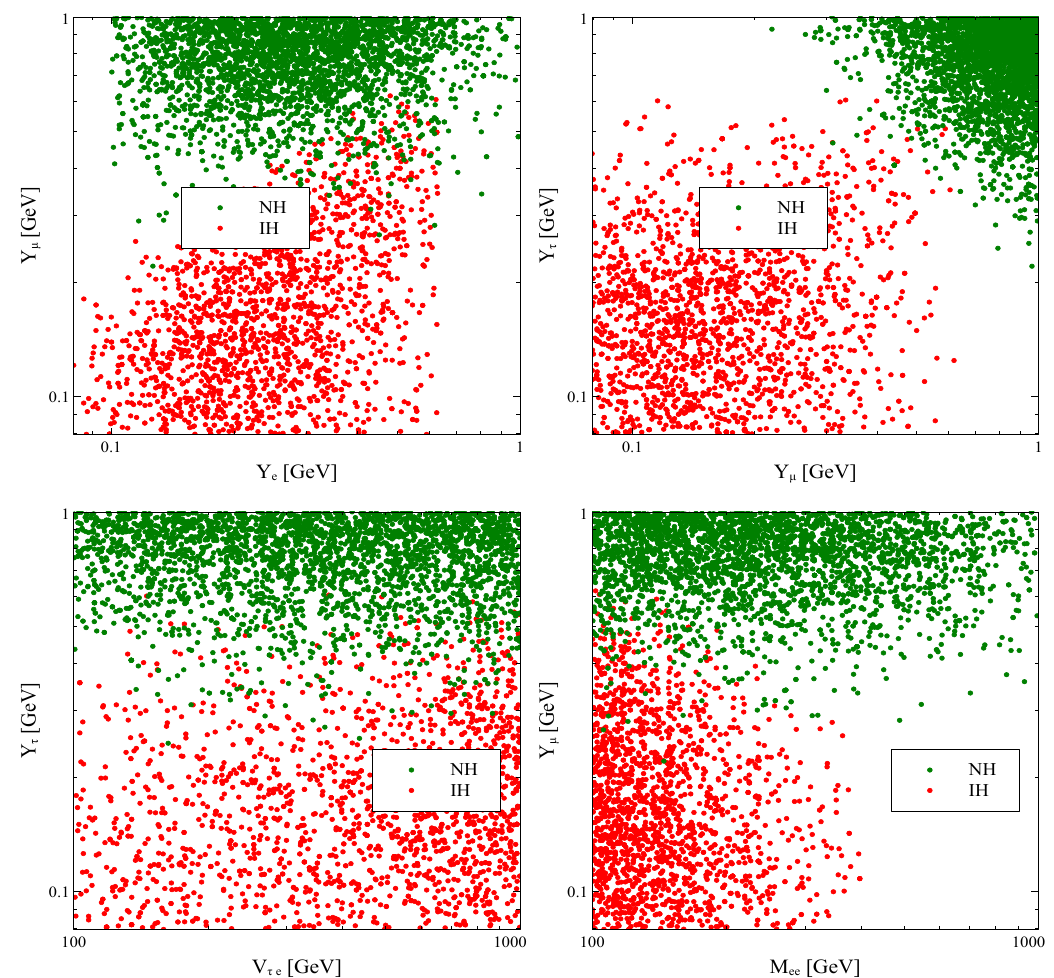
Figure 3 . Each point satis(cid:12)es neutrino oscillation data and there is no overlap between the allowed parameter spaces for NH and IH. All the parameters have been scanned over the ranges as displayed in eq.